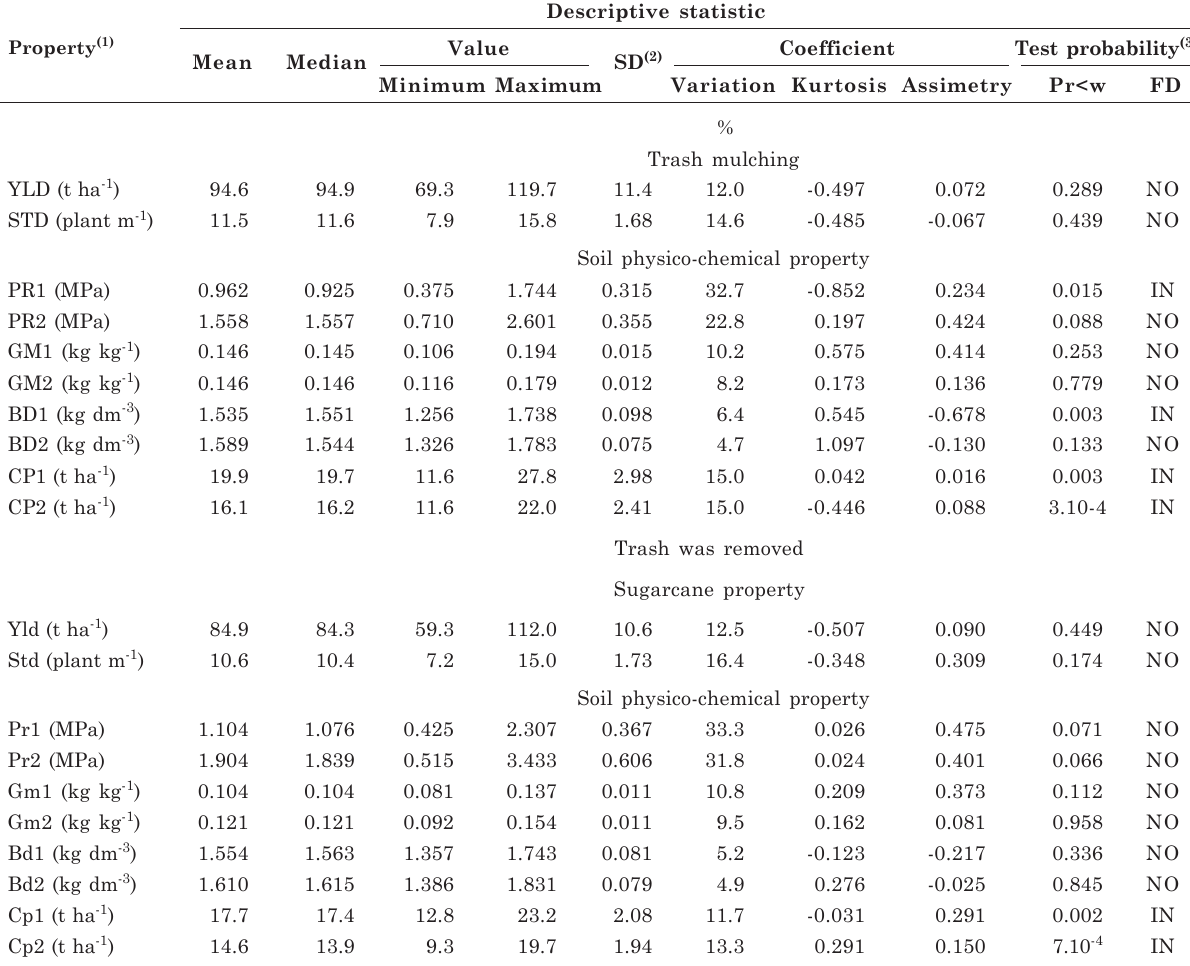
Table 1. Descriptive analysis of properties of sugarcane and physico-chemical properties of an Ultisol, in the trash mulching